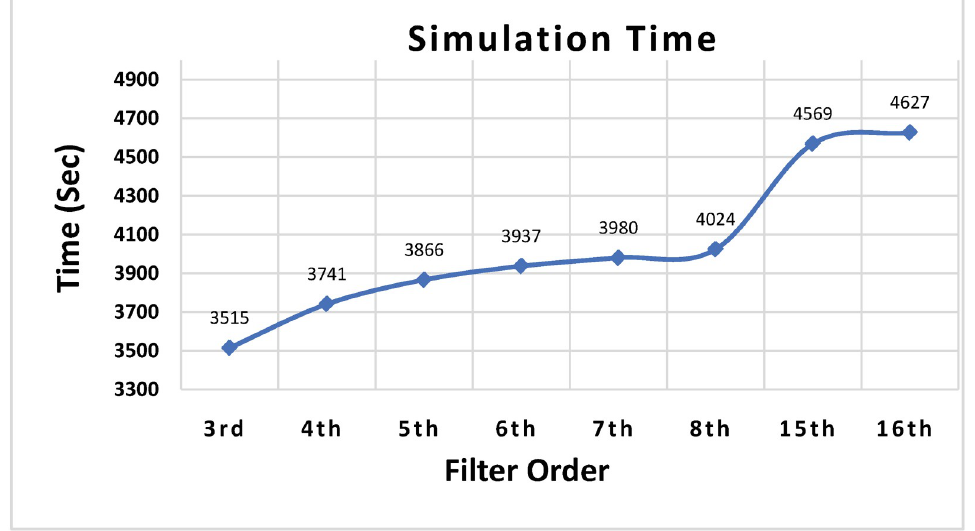
Fig 8. Simulation time of proposed algorithm for different order SC-FIR filters (50 different seed values of LFSR with 2000 input samples for each seed value, a total of 100,000 attempts for each order).